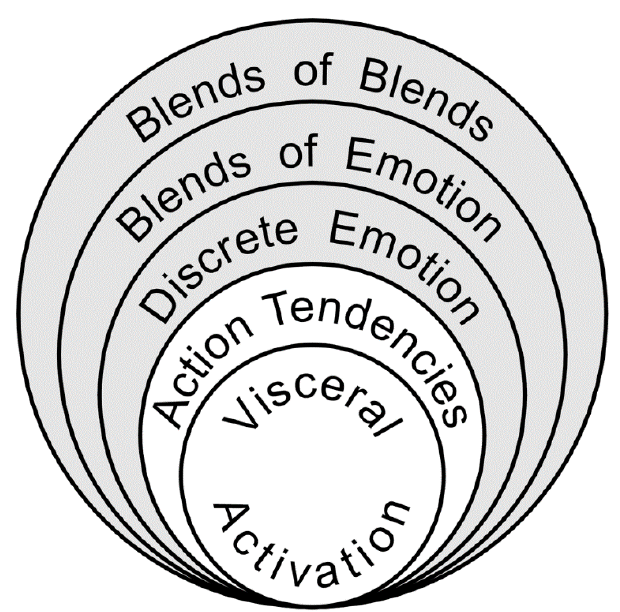
Figure 1. Graphical depiction of Levels of Emotional Awareness as a nested hierarchy.